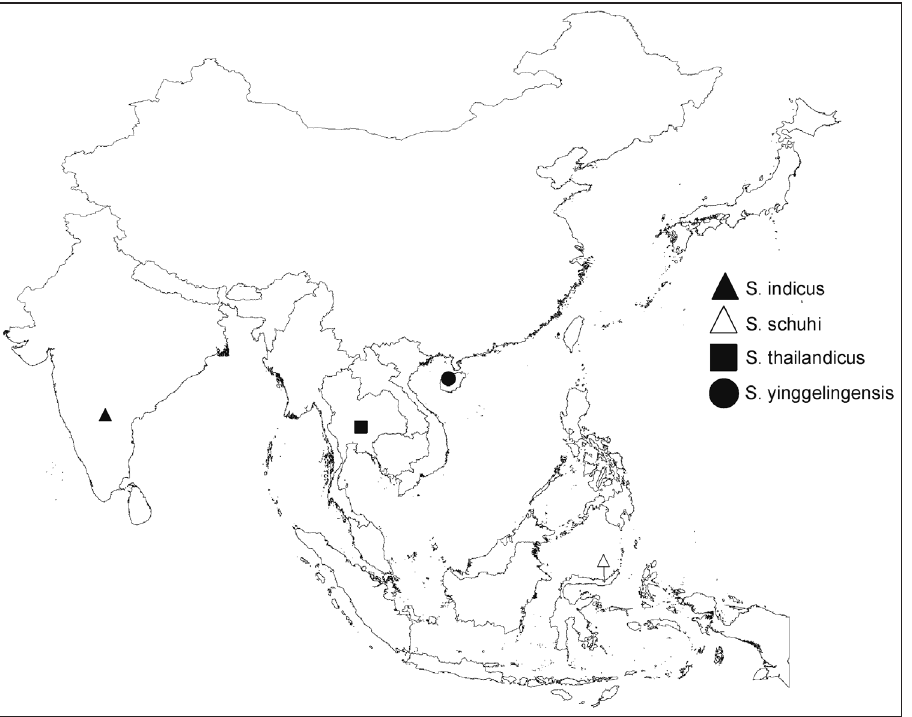
Figure 26. Distribution map of Sulawesifulvius